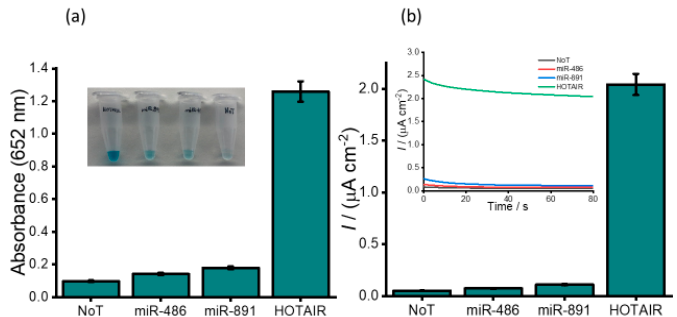
Figure 2. ( a ) Bar diagram corresponding to absorbance obtained for responses for 1.0 pM of miR-486, miR-891 and HOTAIR sequences. ( b ) Bars represent the corresponding current densities for the 1.0 pM of miR-486, miR-891 and HOTAIR sequences. Error bars represent the relative standard deviation of three repeated experiments.